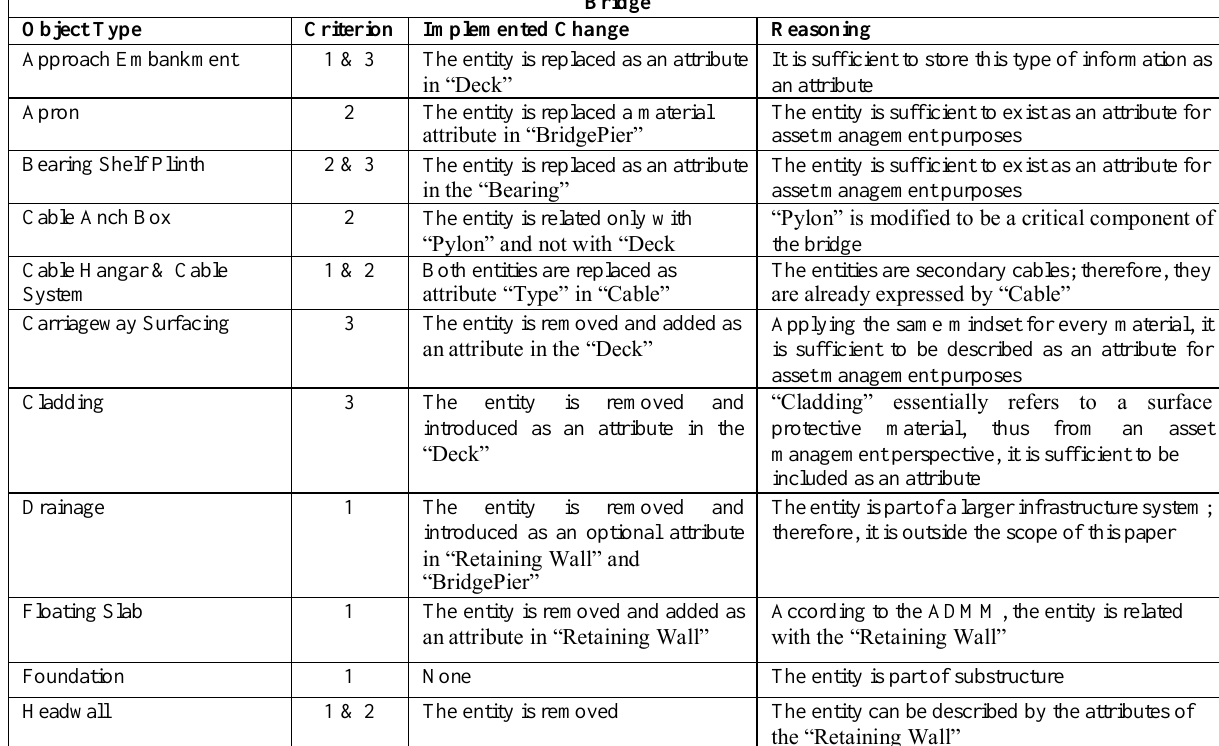
Table 3: Criteria Implementation in Phase 2 for selected types of the